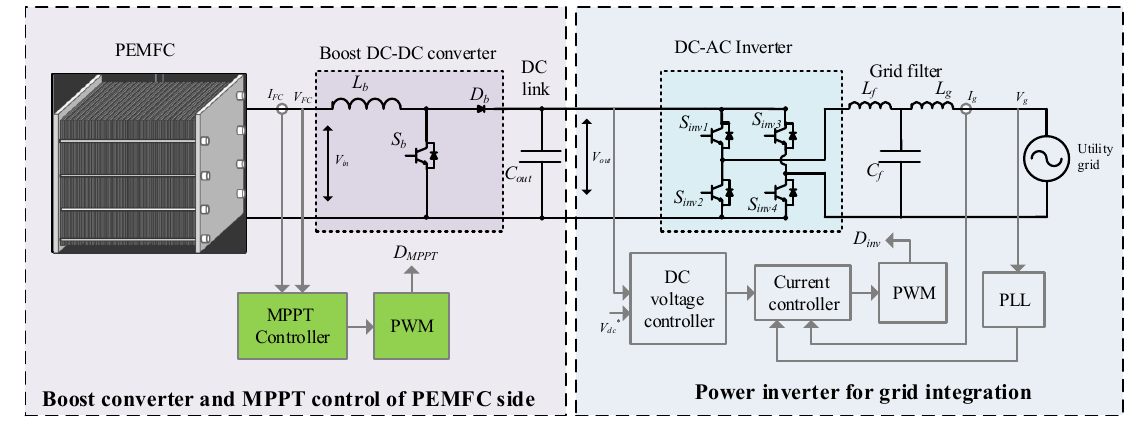
Figure 2. The PEMFC power conversion and MPPT system.